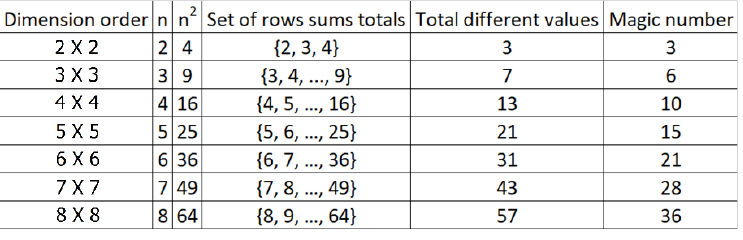
Figure 10. Magic numbers of Borda matrices for n = 2, …, 8 .